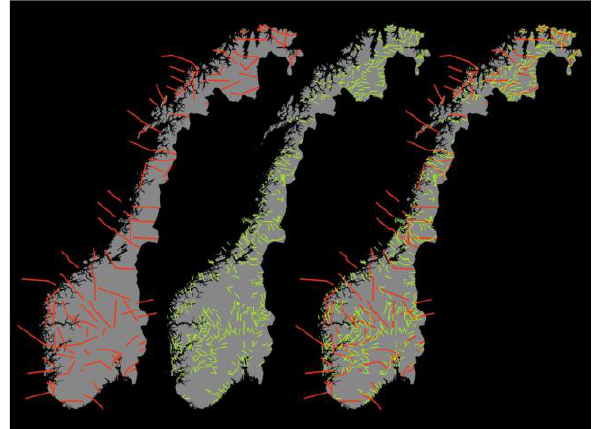
Figure 3: Map of Norway showing the existing 1:250K geological profiles (left in red), the existing 1:50K geological profiles (middle in green) and the combined profiles on the